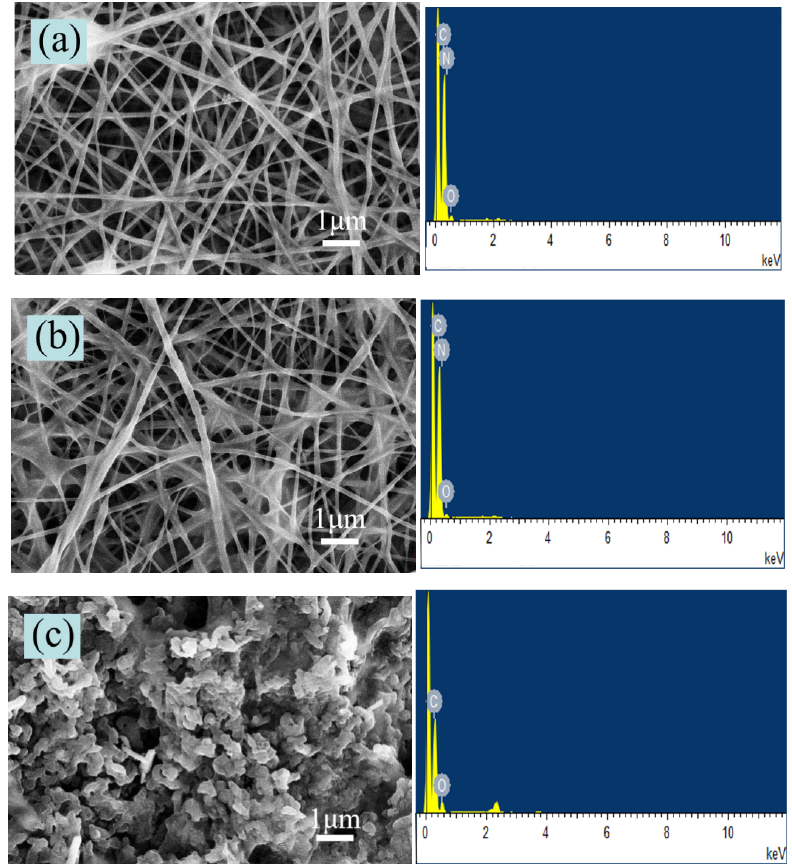
Figure 6. SEM images and EDS results of the 7:5 nanoscale urushiol/PAN film immersed in ( a ) 60%, ( b ) 80%, and ( c ) 100% sulfuric acid solutions.